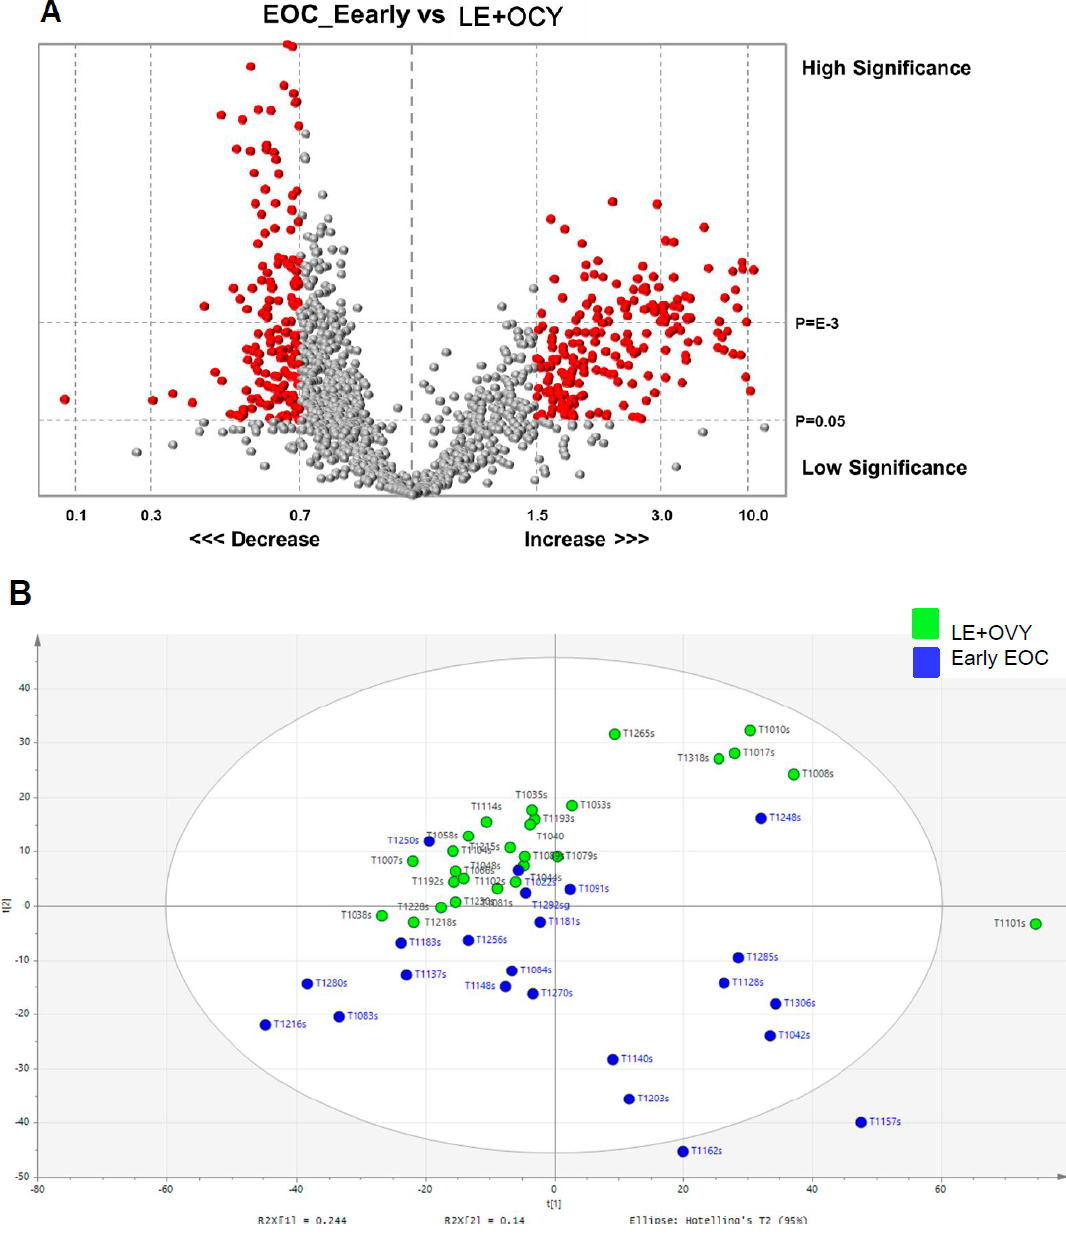
Figure 1. Glycopeptide spectral data in an EOC group and a non-cancer group. ( a ) Volcano plot of serum digested glycopeptide data in early EOC patients compared to non-cancer (LE and OVY) patients. The Y-axis is the p -values determined by the t-test of the mean fold change and the X-axis is the mean fold change. The red dots in the plot represents the differentially expressed glycopeptides with statistical significance ( p < 0.05) and mean fold change of <0.7 or >1.5. The vertical lines in the matrix represent the log 2 fold changes and the horizontal lines in the matrix represent the statistical significance of p < 0.05. ( b ) PCA scatter plot of LE and OVY (green dots) and EOC patient (blue dots) serum samples. The ellipse represents 95% confidence interval. Abbreviations: EOC, epithelial ovarian cancer; LE, leiomyoma; and OVY, ovarian cyst.